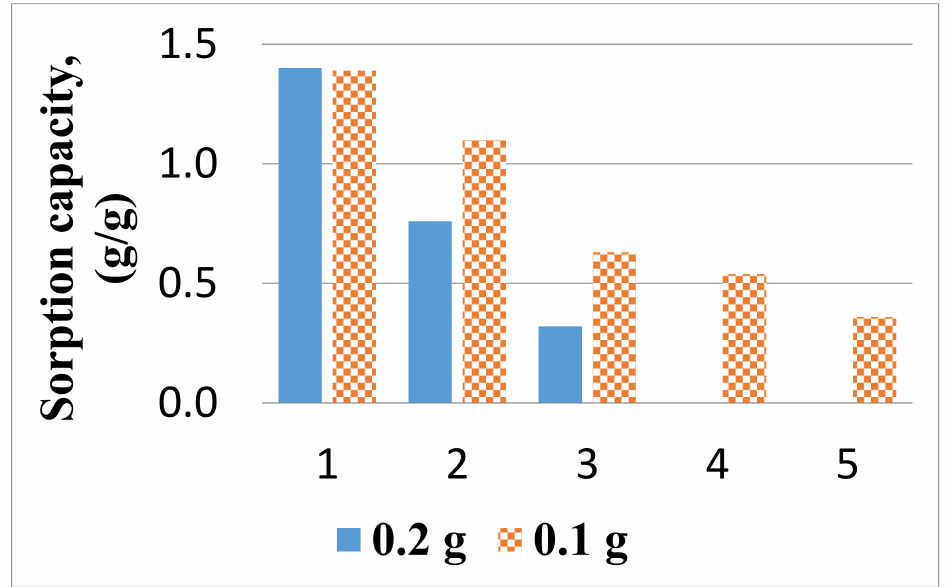
Figure 9. Oil sorption by sample of composite material ChZn of different